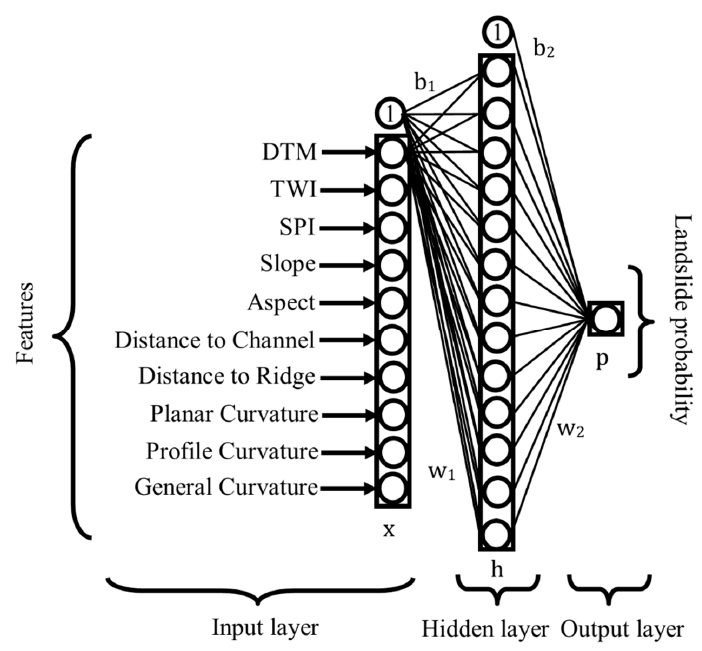
Figure 8. The ANN algorithm used in the study.